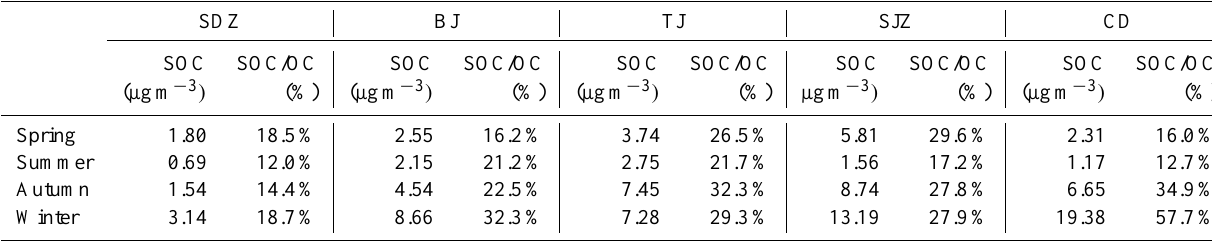
Table 7. Comparisons of heavy metal element concentrations in different studies a (µgm − 3 ) .